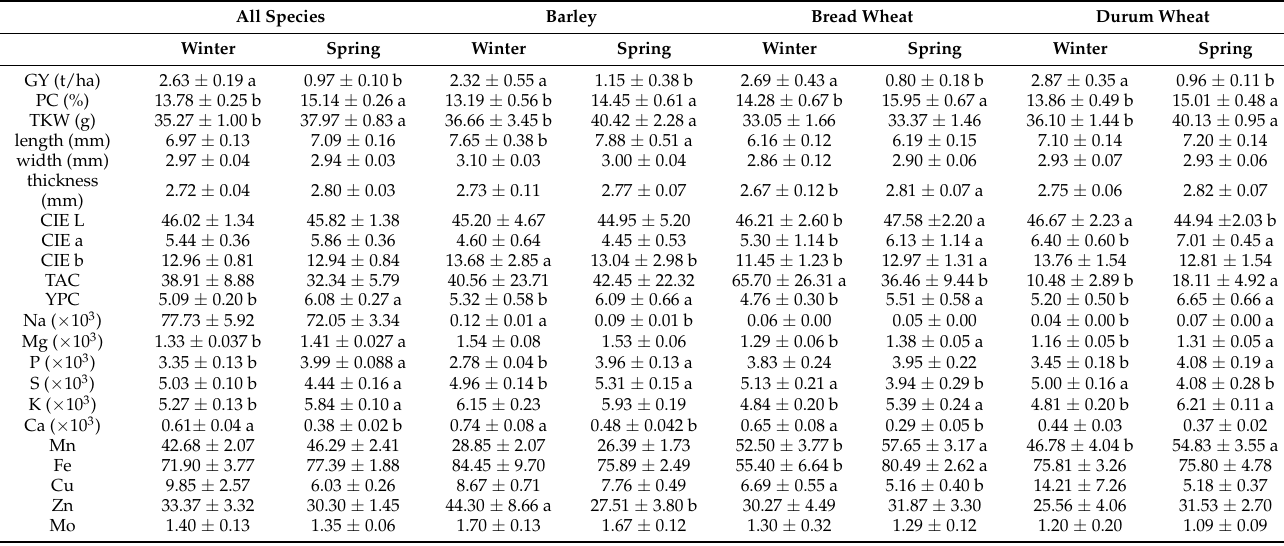
Table 2. Mean value ± SE of each variable investigated in the two different sowing data relating to the whole data set and specific to each